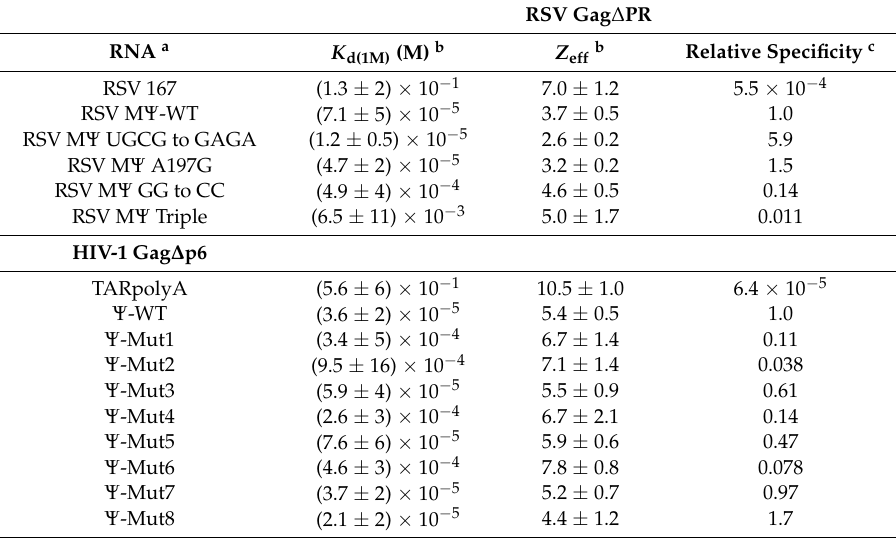
Table 3. Binding parameters determined from FA salt-titration assays of WT Gag proteins with non- Ψ RNA, WT Ψ , and mutant Ψ